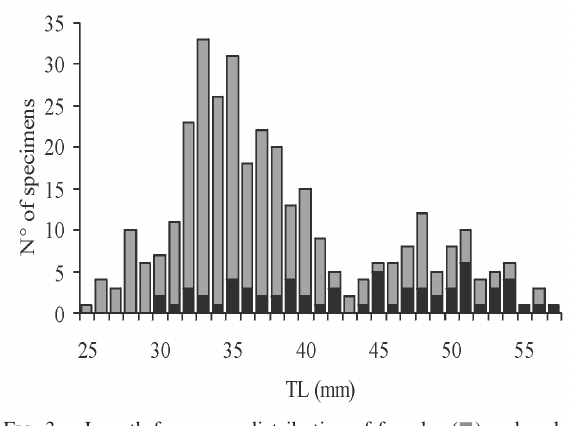
Fig. 3. – Length frequency distribution of females ( n ) and males ( n ) A. minuta from coastal waters off Comacchio.